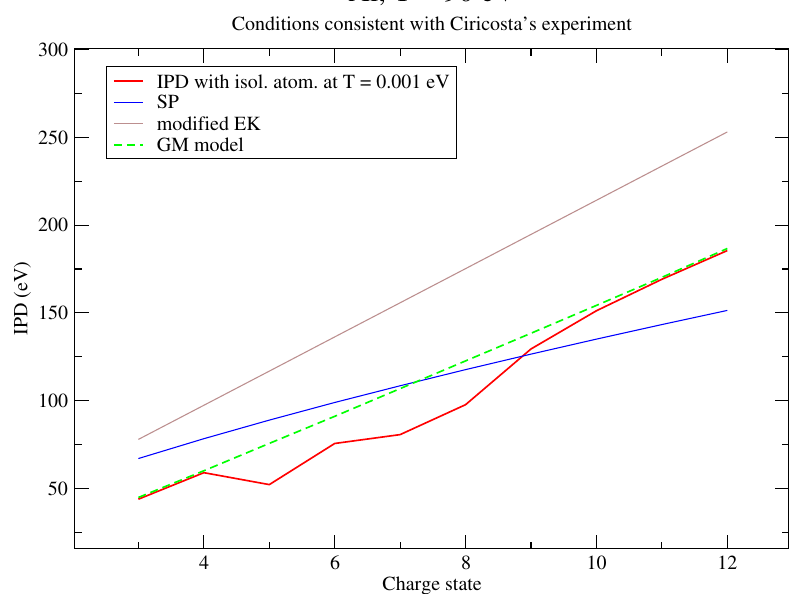
Figure 9. IPD of the different charge states for an aluminum plasma at T = 90 eV: our calculation (red curve), Stewart-Pyatt model (blue curve), modified Ecker-Kröll model (brown curve) and GM model (green dashed